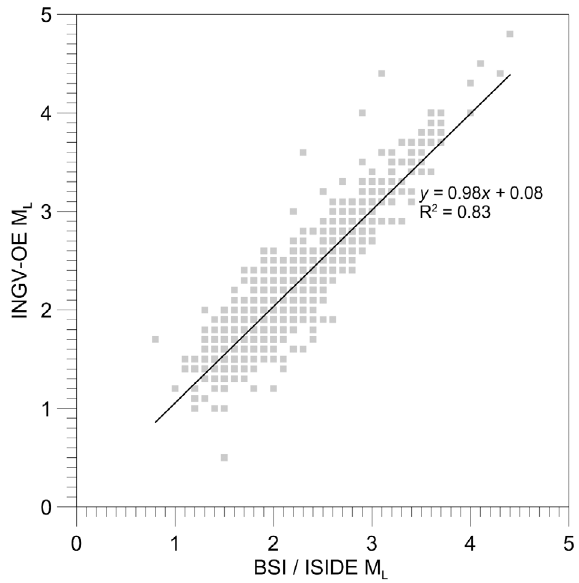
values of earthquakes occurring at Mt. Etna Figure 2. Plot of M L from 2005 to 2014 calculated by both local and national seismic net- work. y -coordinate data from Mt. Etna permanent seismic network [Gruppo analisi dati sismici 2015]; x -coordinate data from the Ital- ian Seismic Bulletin [BSI 2012] and Italian Seismological Instru- mental and Parametrical Database [ISIDE 2015].